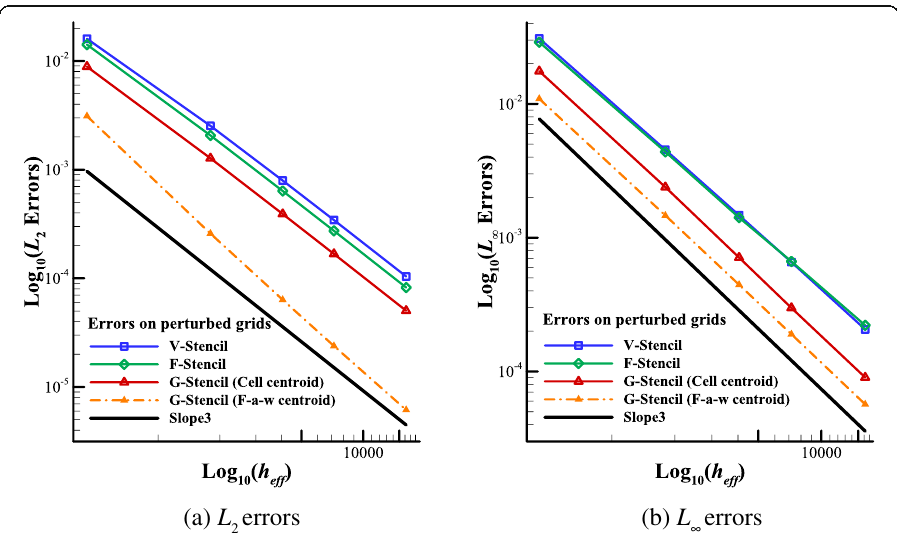
Fig. 41 ( a ) L 2 and ( b ) L ∞ errors. Errors of different stencils on randomly perturbed triangular grids with AR =10